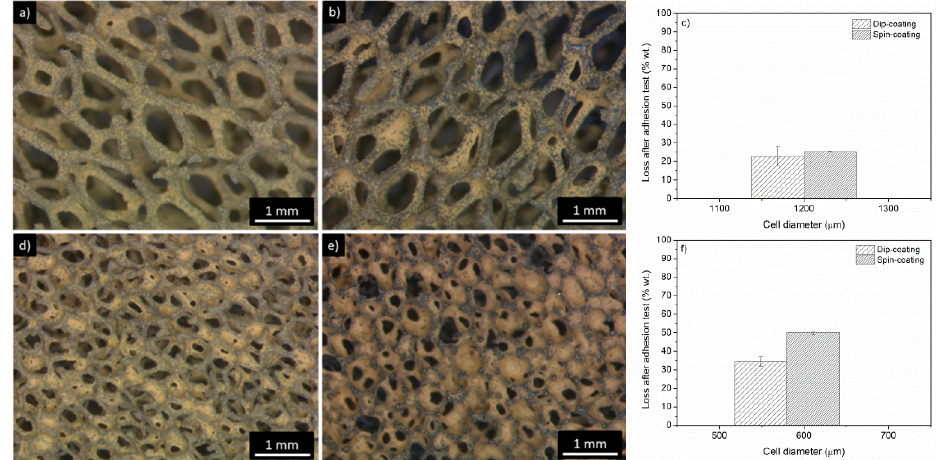
Figure 5. Optical microscope analysis of spin-coated ( a , d ) and dip-coated ( b , e ) foams of 1200 μ m ( a , b ) and 580 μ m ( d , e ) cell diameters. Losses after adhesion tests are reported in ( c , f ) for S1200 and S580 samples, respectively.